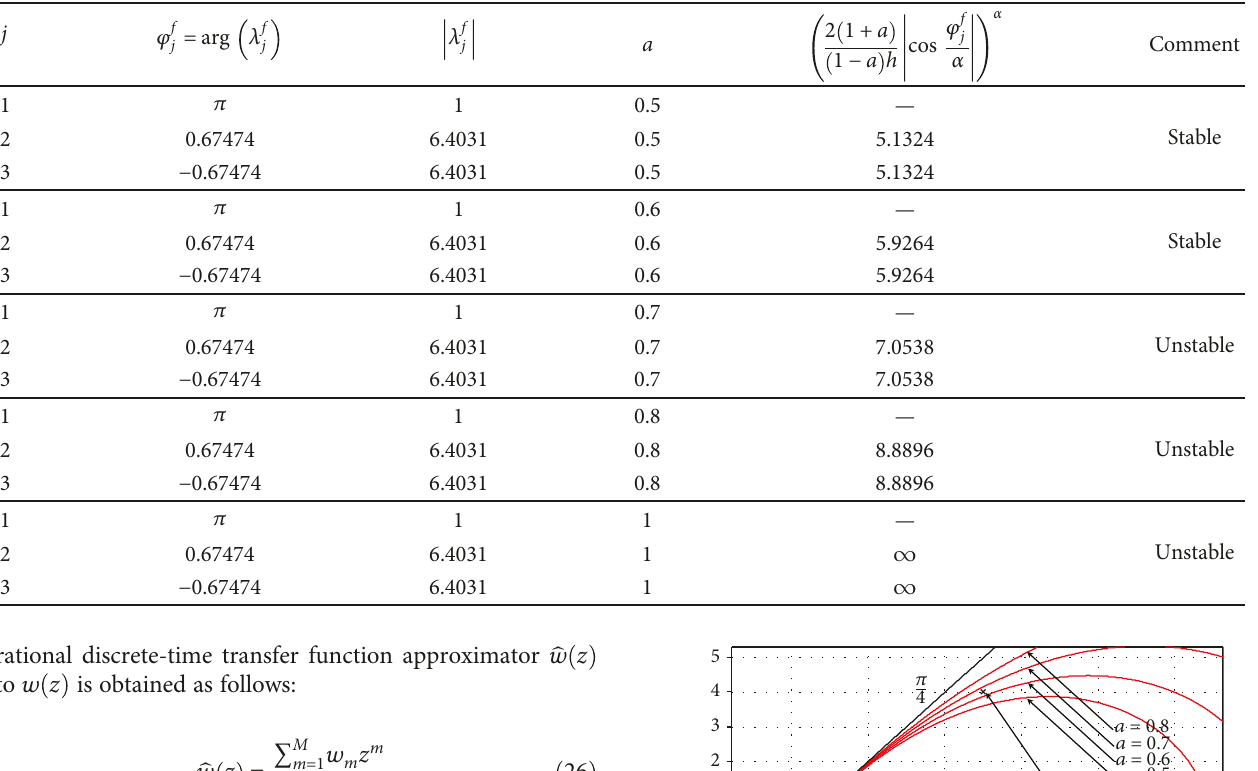
Table 1: Stability properties of discretized fractional-order system; Example 1.